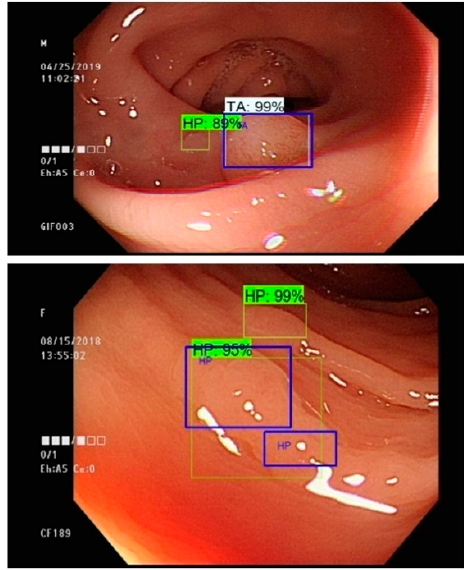
Figure 8. The detection outcomes using Faster R-CNN with Inception v2 network structure (blue box: expert annotated region, other: machine prediction).